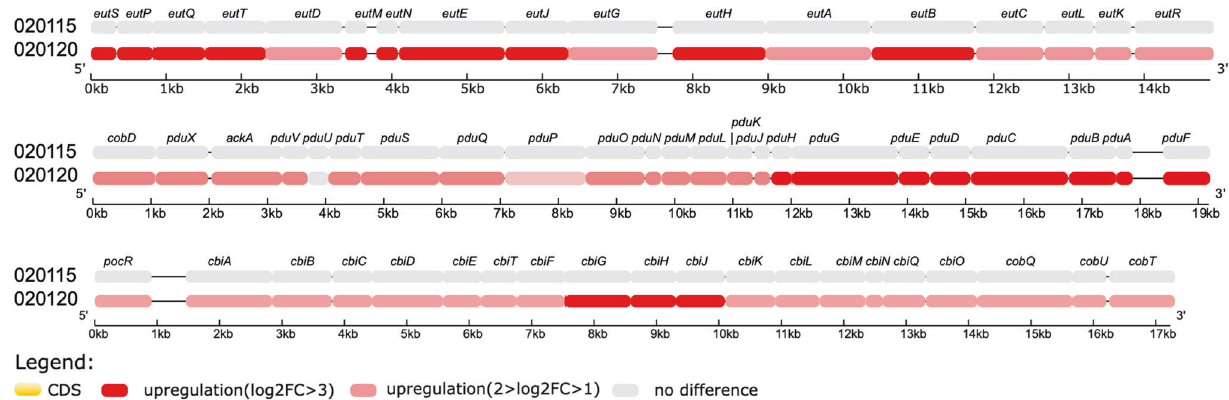
Fig. 6 Differential expression level of C1_020120 or C2_020115 in ethanolamine, 1,2-propanediol, and cobalamin pathways. Differential expression level of C1_020120 or C2_020115 between when co-fed together and when fed alone in pathways for ethanolamine utilization (the eut gene cluster), 1,2-propanediol metabolism (the pdu gene cluster), and cobalamin biosynthesis (the cbi/cob gene cluster) are demonstrated in colours. The exact change in log2fold of these genes are shown in Dataset S5, and their function is listed in Dataset